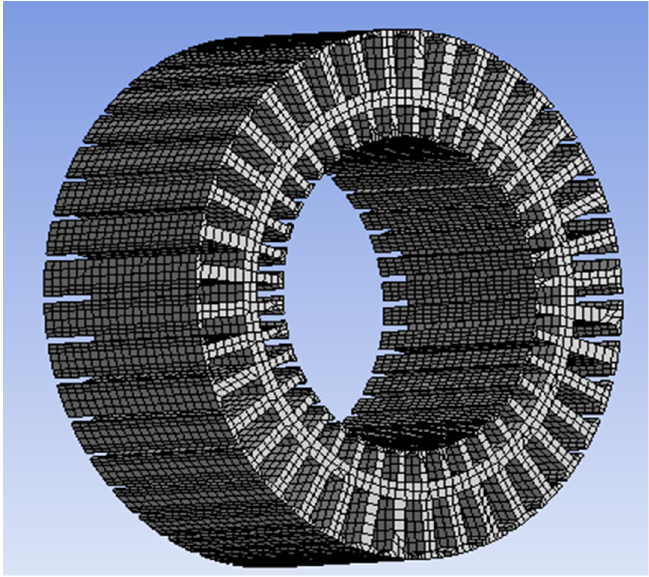
Figure 18. Mesh partition of stator of 1 kW DRPMSM.